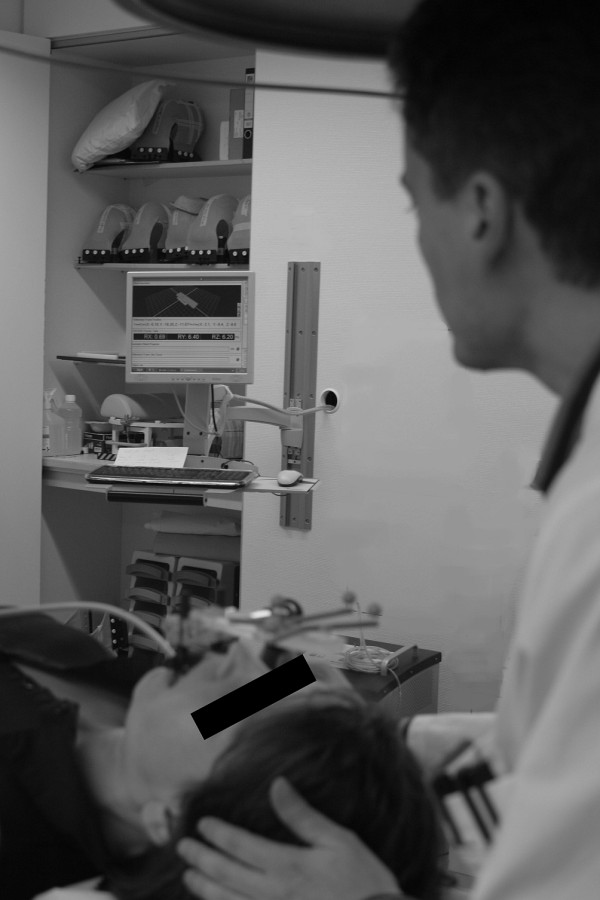
Manual prepositioning. A subjects head is rotated around all 3 room axes to < ± 2°. Note how the head is manipulated with one hand, the mechanical arm with the other hand. The required infrared-based translations and rotations are read off the treatment room iGuide screen, visible in the background.